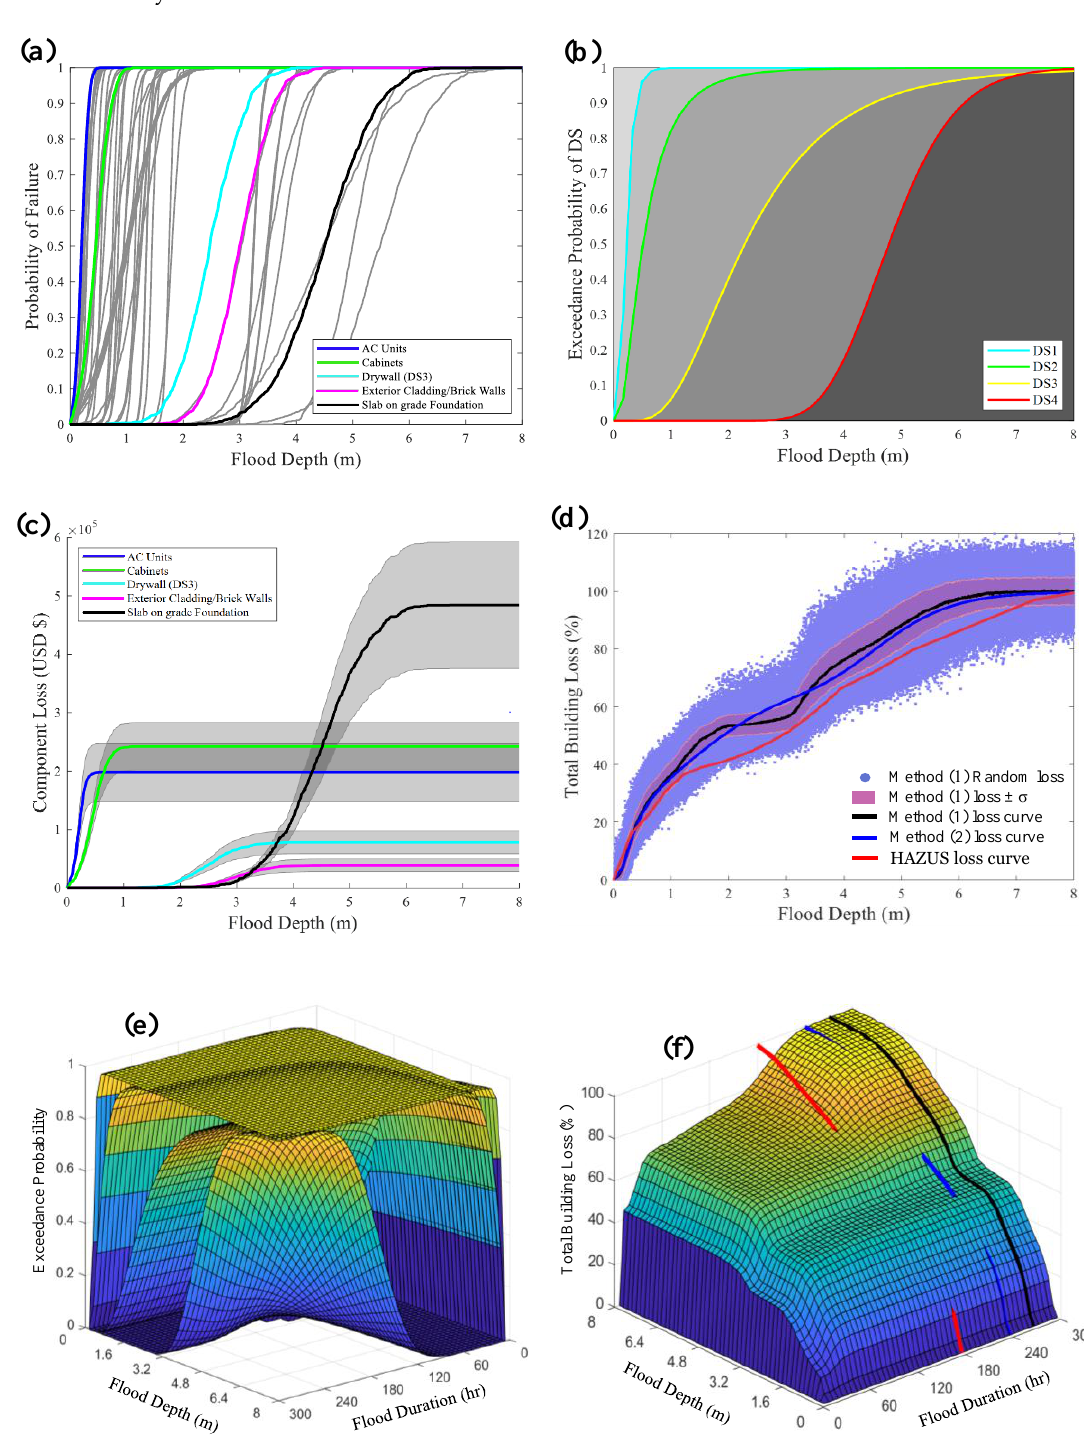
Figure A24. F10 archetype analysis results: ( a ) Component fragility curves; ( b ) Building fragility curves; ( c ) Selected components’ loss curves; ( d ) Building loss curves; ( e ) Building fragility surfaces; ( f ) Building loss surface.